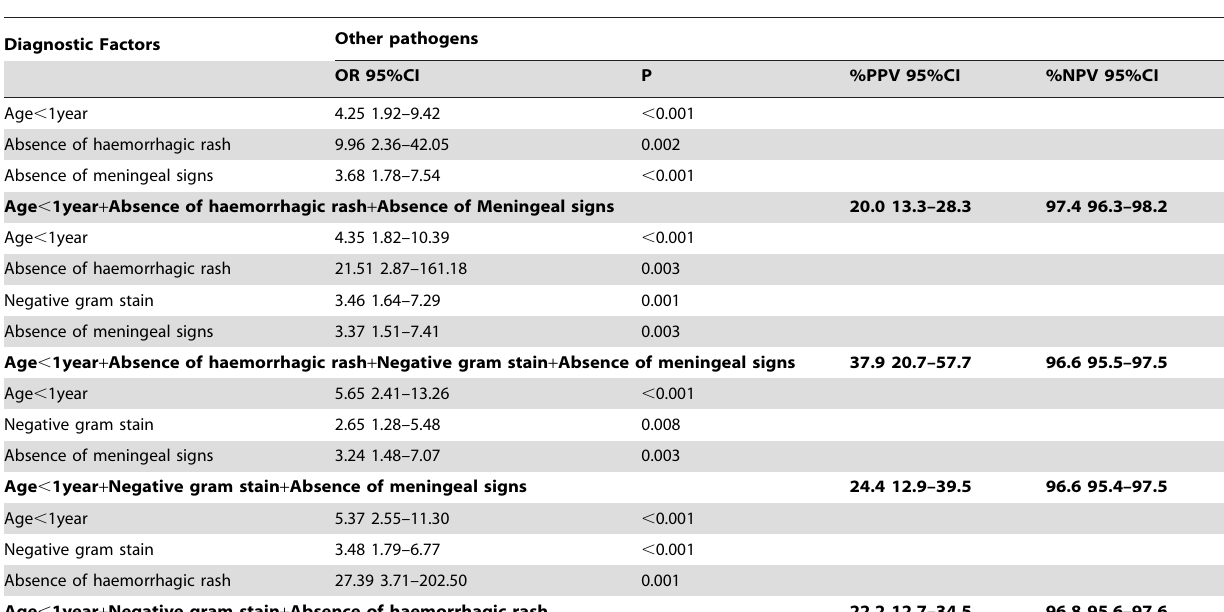
Table 9. Multivariate analysis of groups of diagnostic factors for the diagnosis of ‘other